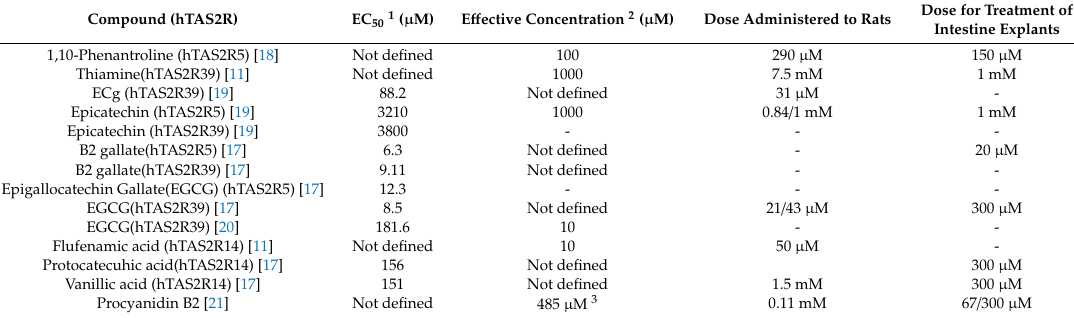
Table 1. Comparison of the doses of the agonists and ligands assayed in the study and the individual binding parameters defined for